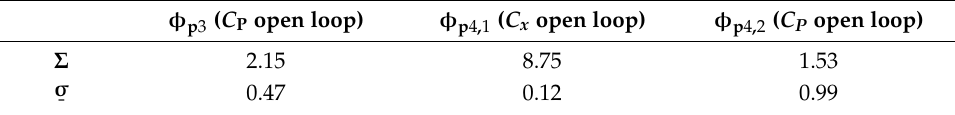
Table 6. Mean condition number and minimum singular value for low order structures.